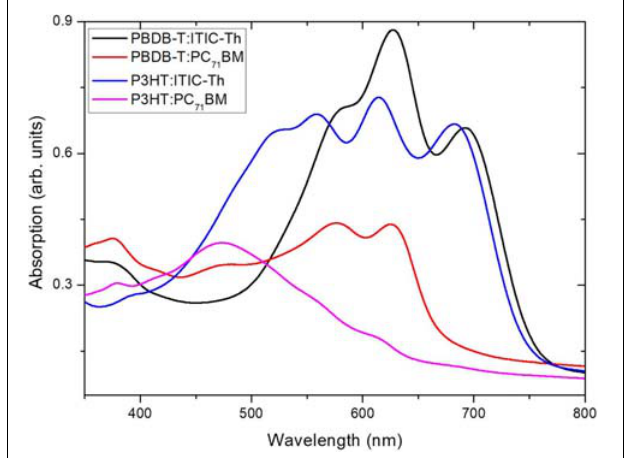
FIGURE 2 | Absorption spectra of different D:A thin films